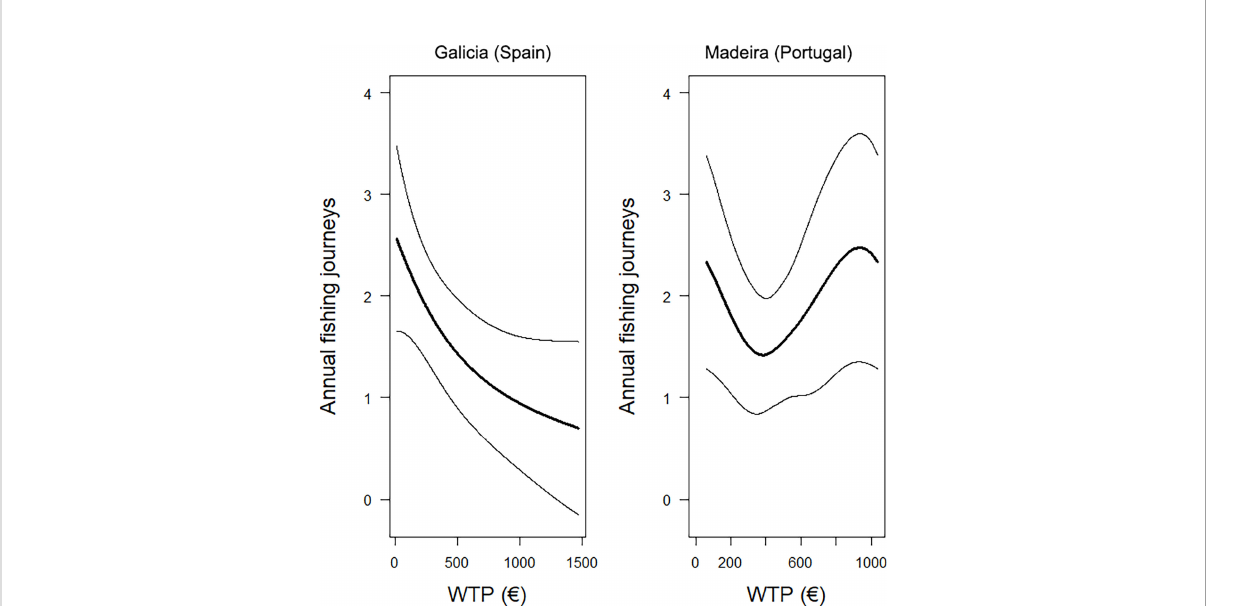
FIGURE 4 Partial effect of the WTP (as a function of the travel cost) on the number of fi shing journeys to Spain (Galicia) and Portugal (Madeira). It is shown the prediction (dark lines), and their 95% con fi dence interval (thin lines) estimated by the adjusted GAMs.